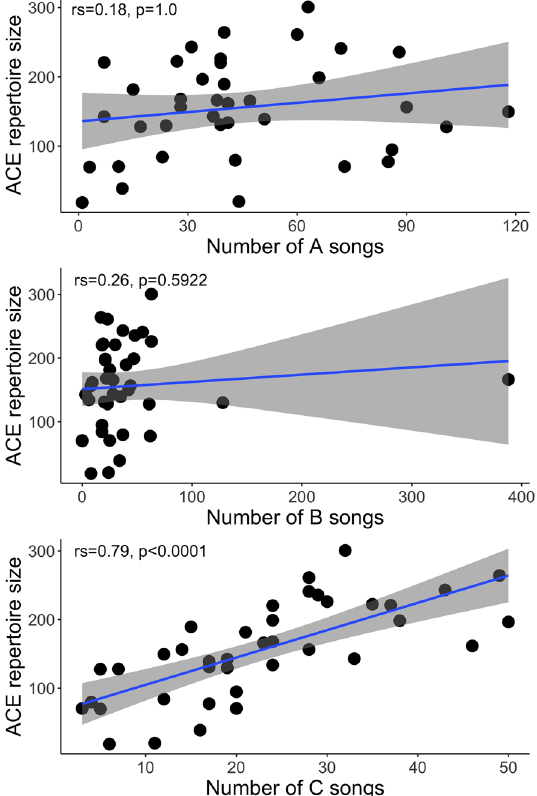
Figure 5. Correlations between numbers of A-, B- and C-songs recorded from males and the ACE, one of the best estimators of the entire phrase repertoire size.